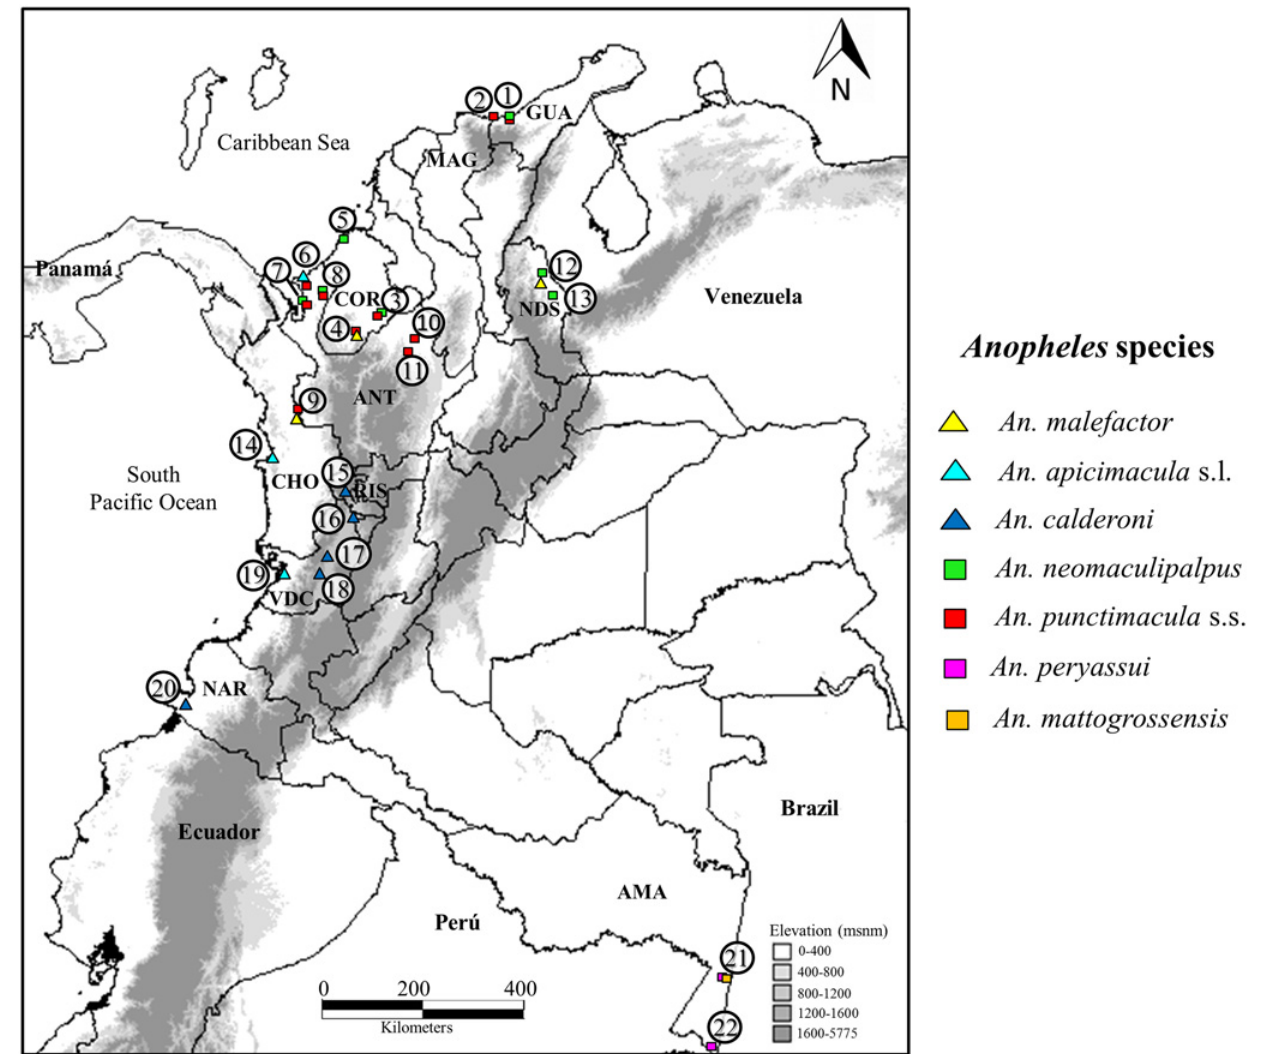
Fig 1. Map of collection sites for Arribalzagia Series species. Departments are noted with three letter codes. AMA: Amazonas; ANT: Antioquia; CHO: Chocó; COR: Córdoba; GUA: La Guajira; MAG: Magdalena; NAR: Nari ñ o; NDS: Norte de Santander; RIS: Risaralda; VDC: Valle del Cauca. Identical symbols indicate the same species. Numbers on the map indicate collections sites detailed in Table